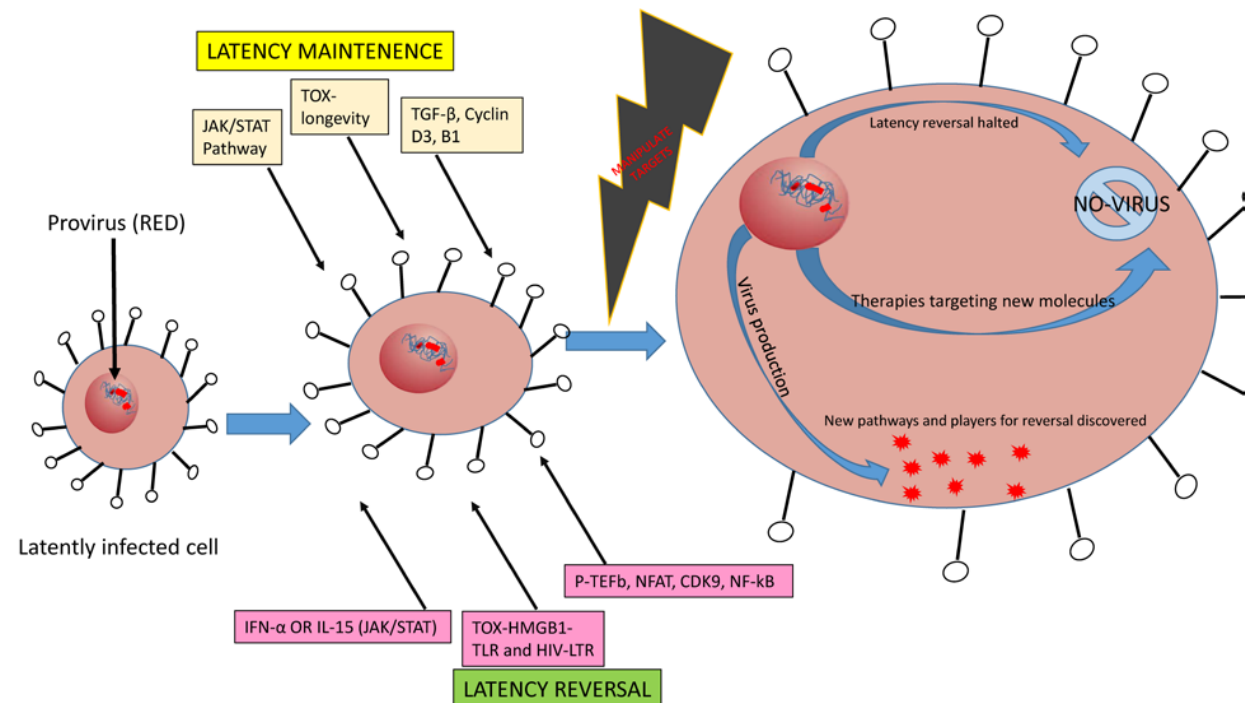
Figure 1. A model depicting the dual/mixed roles of signaling molecules/pathways involved in the maintenance/upkeep and/or reversal of HIV latency. Some of these molecules/pathways show effects in both reversion and/or upkeep, depending on the upstream/downstream molecules involved and compounds, agents, and molecules used during cell culture/stimulation conditions. Targeting these regulatory molecules/pathways with various agents, drugs, vaccines, or antibodies may lead to new therapeutics for viral reactivation and latency reversal, or perhaps even upkeep/maintenance. In addition, manipulating these individual effectors at the genetic or epigenetic level may also affect either latency reversal or maintenance. Components associated with effector protein family or signaling cascades such as JAK/STAT and TOX can play dual roles. Understanding the roles of these effectors, as well as their working conditions, may facilitate targeting those molecules/pathways to cure HIV.